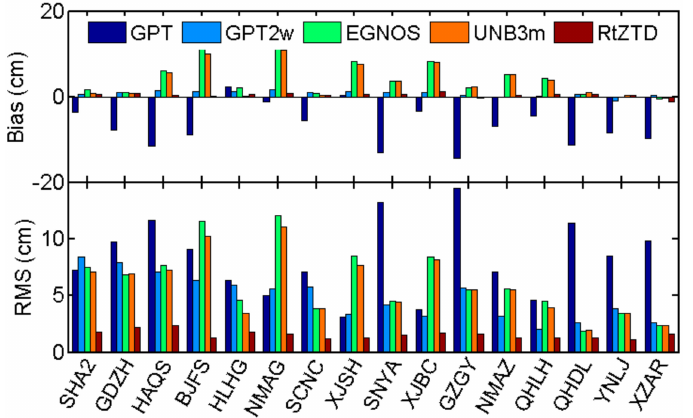
Figure 7. Comparison of GPT, GPT2, EGNOS, UNB3m model and RTZTD (stations sorted in ascending